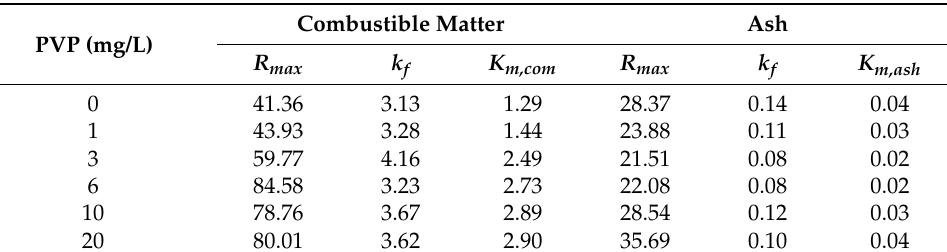
Table 3. Flotation kinetic parameters ( R max , k f , and K m ) with varying PVP concentrations.